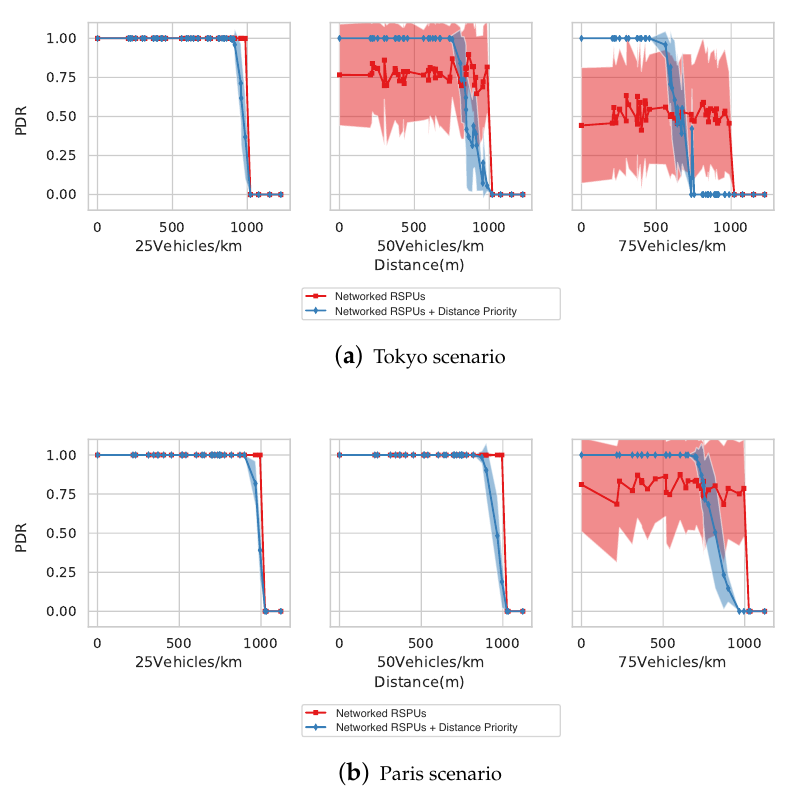
Figure 11. Evaluation of packet delivery ratio (PDR). ( a ) Tokyo scenarios, ( b ) Paris